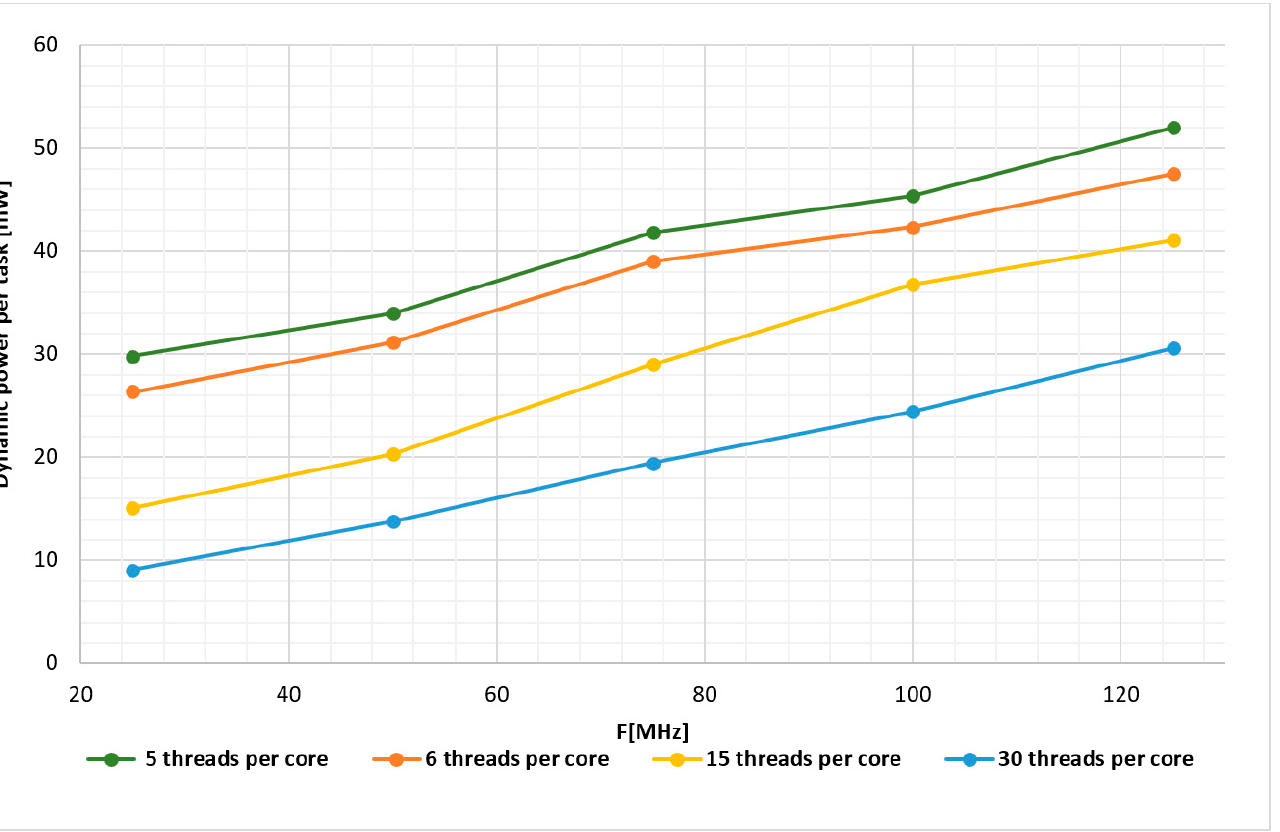
Figure 17. Relationship between the average power per task and the operating frequency for different MTP RG structures (various numbers of tasks processed by a single core).